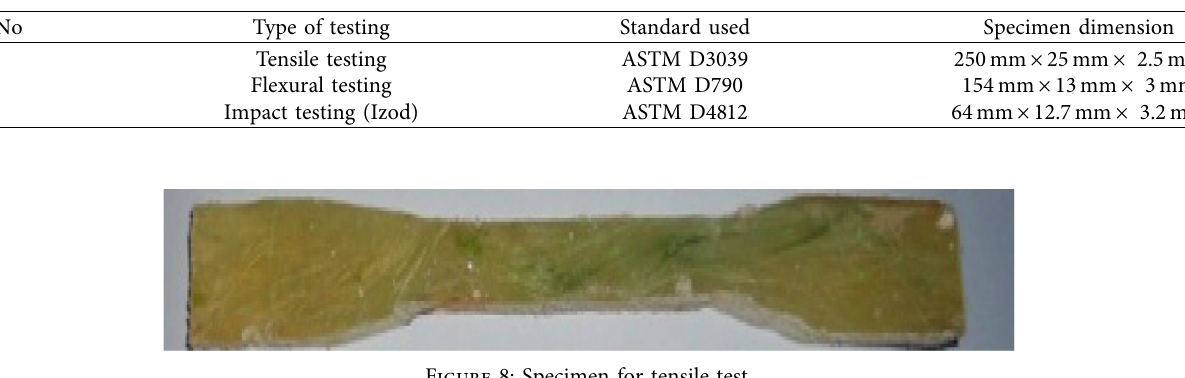
Table 3: Test specimen standards with dimension.